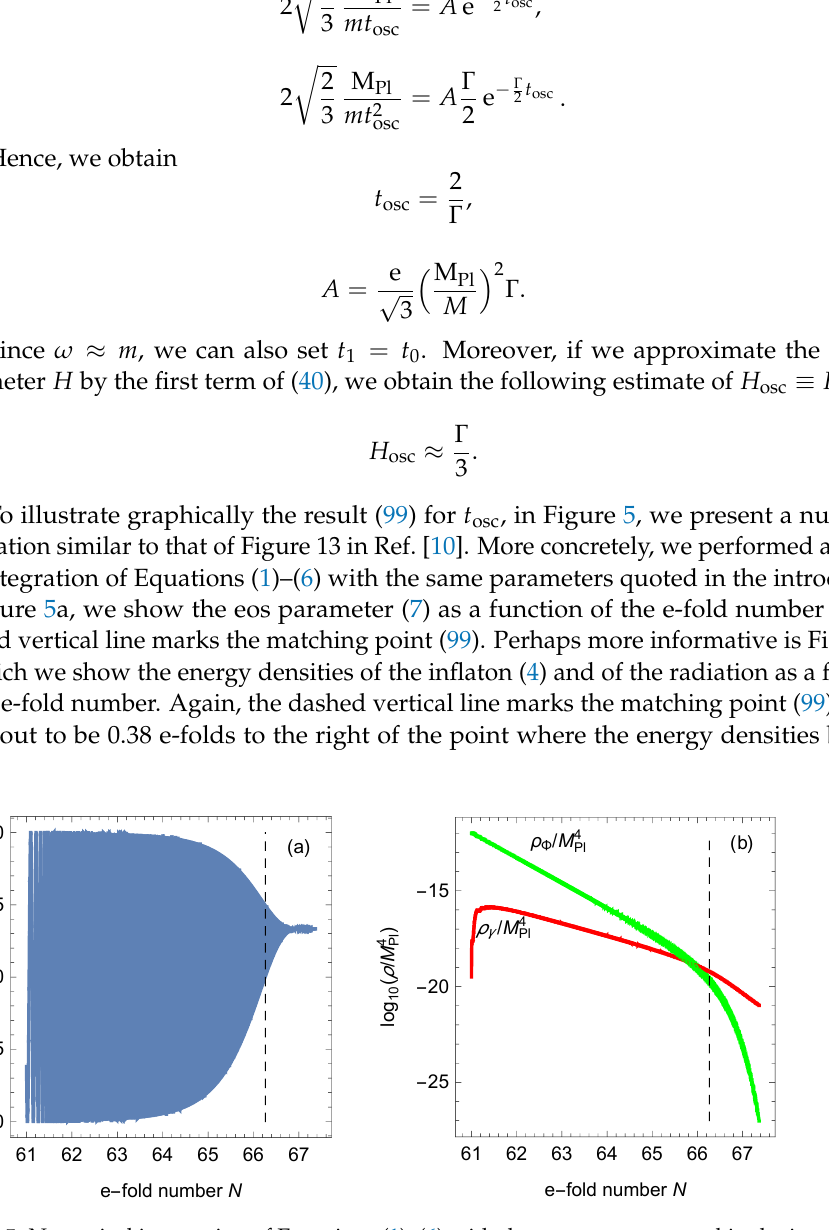
Figure 5. Numerical integration of Equations (1)–(6) with the parameters quoted in the introduction. ( a ) The eos parameter w re as a function of the e-fold number N . ( b ) Inflaton and radiation energy densities. In both cases, the dashed vertical line marks the matching point t osc = 2/ Γ